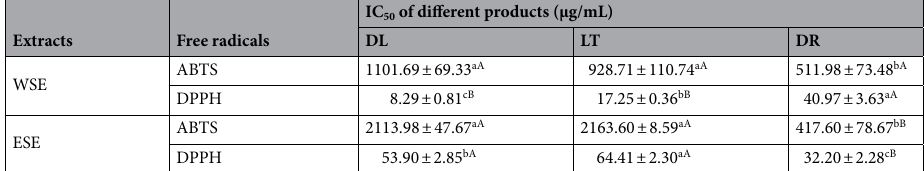
Table 3. Semi-lethal inhibitory concentration (IC 50 ) of water and ethanol extracts of three products of Astragalus membranaceus (Fisch.) Bge. to ABTS and DPPH free radicals. Data indicated mean ± SD. ABTS, 2,2-azino-bis-(3-ethylbenzothiazoline-6-sulfonic acid); DPPH, 2,2-diphenyl-1-picrylhydrazyl. Different superscript lowercase letters mean significant difference at P < 0.05, and superscript uppercase letters